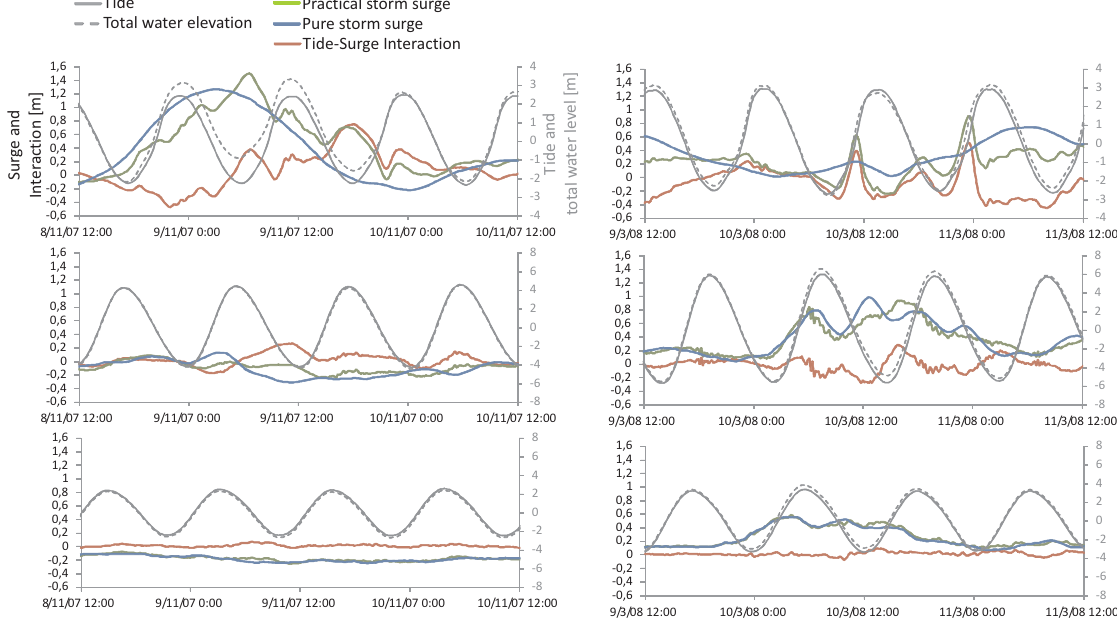
I (right), for the two events of November 2007 (above) and March 2008 (below). Data interval: 12-minutes.